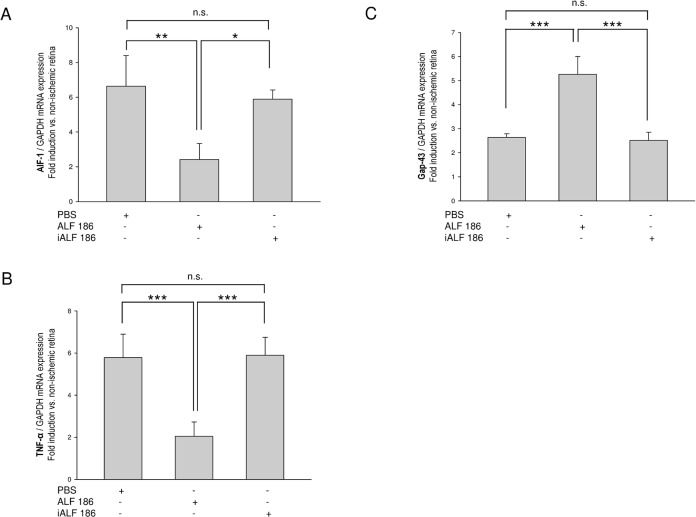
Effect of ALF-186 on AIF-1, TNF-α, and Gap-43 mRNA expression.(A) Fold induction of AIF-1 mRNA expression after IRI (n = 6; data are mean±SD; ** = p<0.05; * = p<0.05). (B) Fold induction of TNF-α mRNA expression after ALF-186 (n = 6; data are mean±SD; *** = p<0.001). (C) Fold induction of Gap-43 mRNA expression after ALF-186 (n = 6; data are mean±SD; both *** = p<0.001).